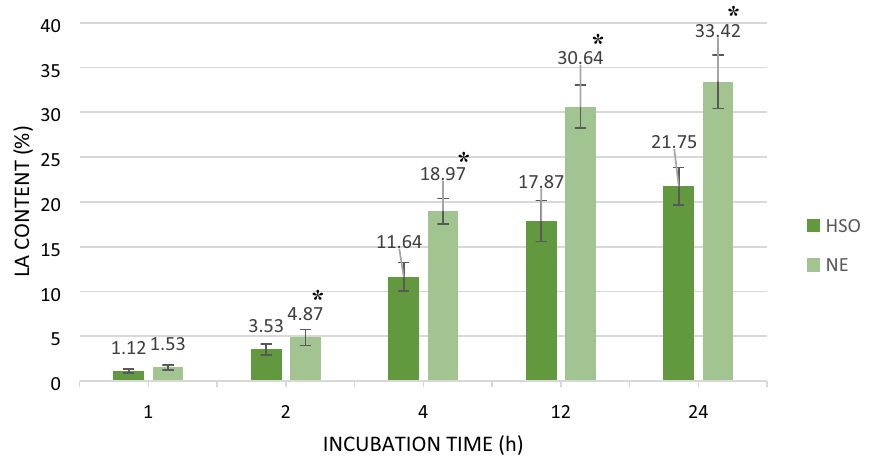
Figure 7. Linoleic acid (LA) recovery in basolateral chamber of Caco-2 cell culture treated with HSO and nanoemulsion. Each point represents the mean value ± SD ( n = 3). *Significant values ( p < 0.05) in comparison with